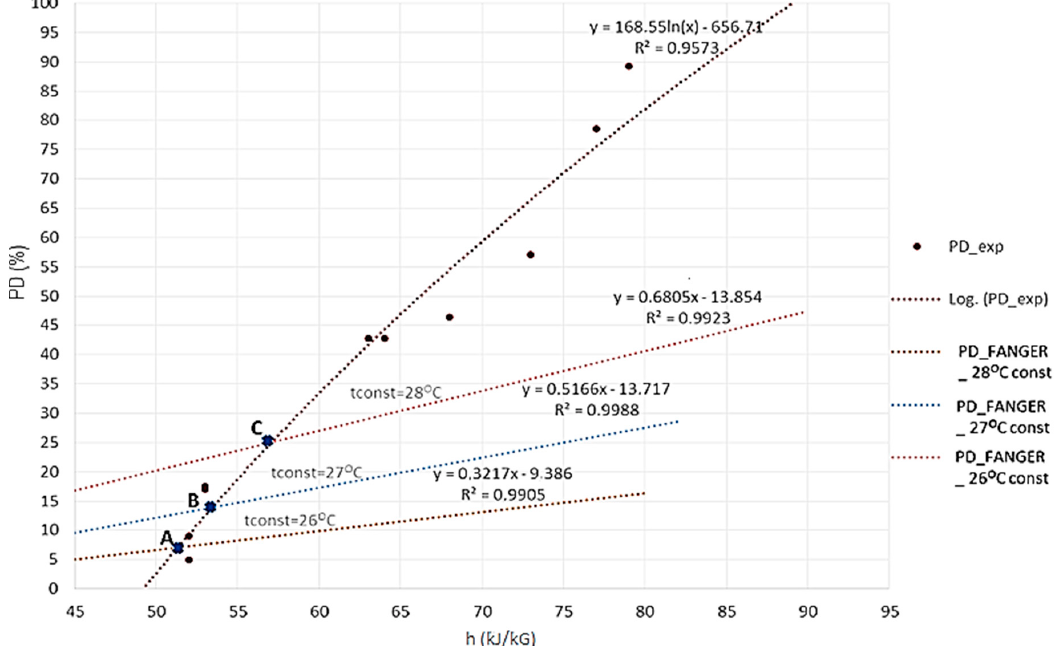
Figure 7. Comparison of the panel test results (black dots) of indoor air perception ( PD_exp ) with the results estimated using the thermal comfort model ( PD_ ISO7730 ) for three constant temperatures: 26, 27 and 28 °C (under the assumptions: air speed < 0.1 m/s, 0.6 clo, 1.1 Met, t a = t mr ). Intersection points are presented in the graph with dots marked A, B and C. The PD_Fanger lines are interrupted in points where RH reaches 100%.